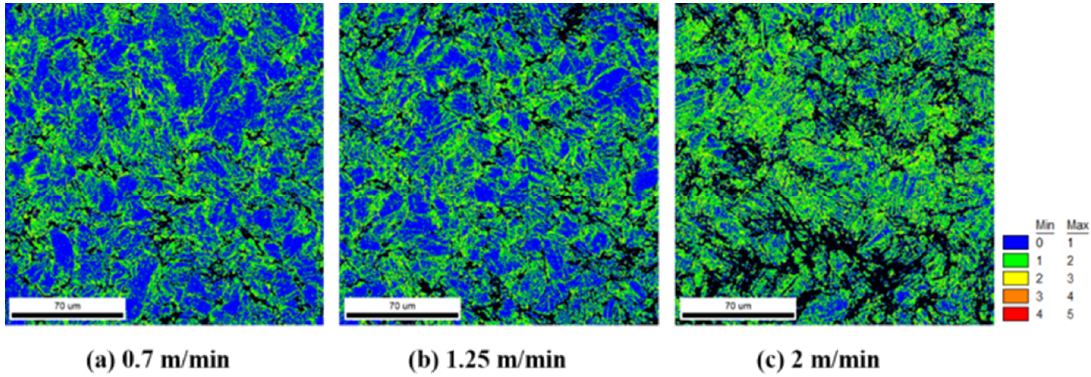
12 of 16 Figure 11. The residual stress variation with depth for the 25% swaged samples: ( a ) 0.7 m/min, ( b )